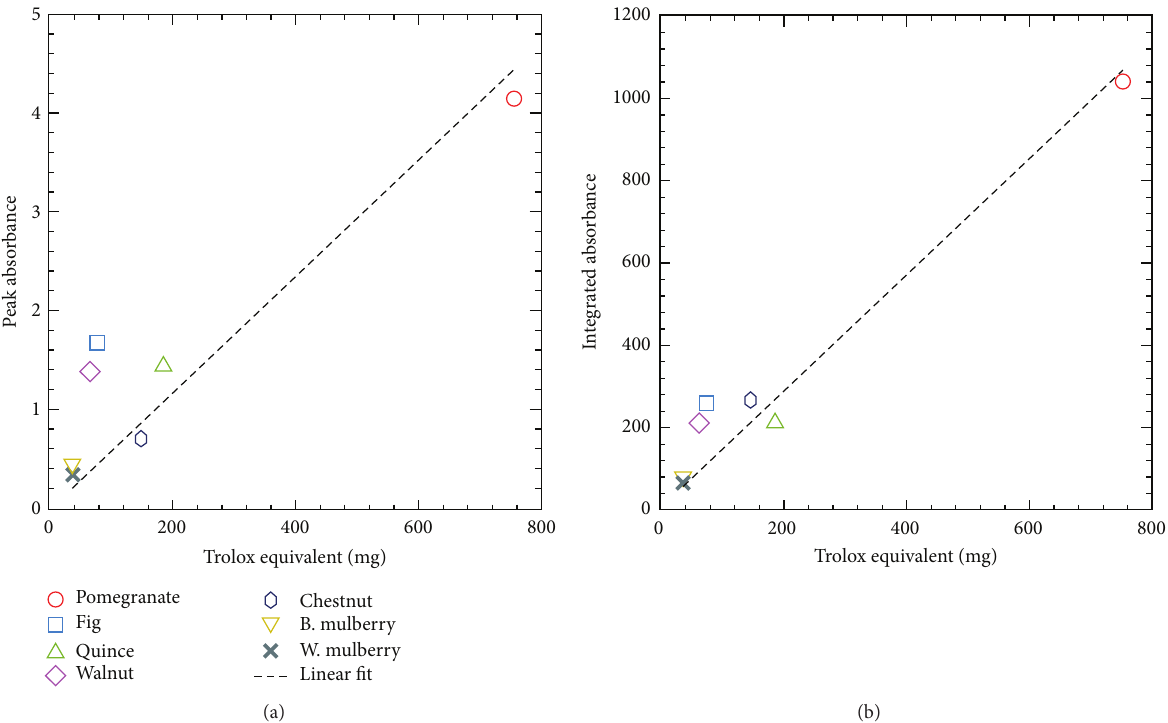
Figure 4: SPR peak absorbance (a) and integrated absorbance (b) between 300 and 800 nm for the mixtures in Figure 3(a) against the trolox equivalence of corresponding plant leaf extracts. Baseline subtraction is performed before the integration for data in (b). Dashed lines indicate the best fits to